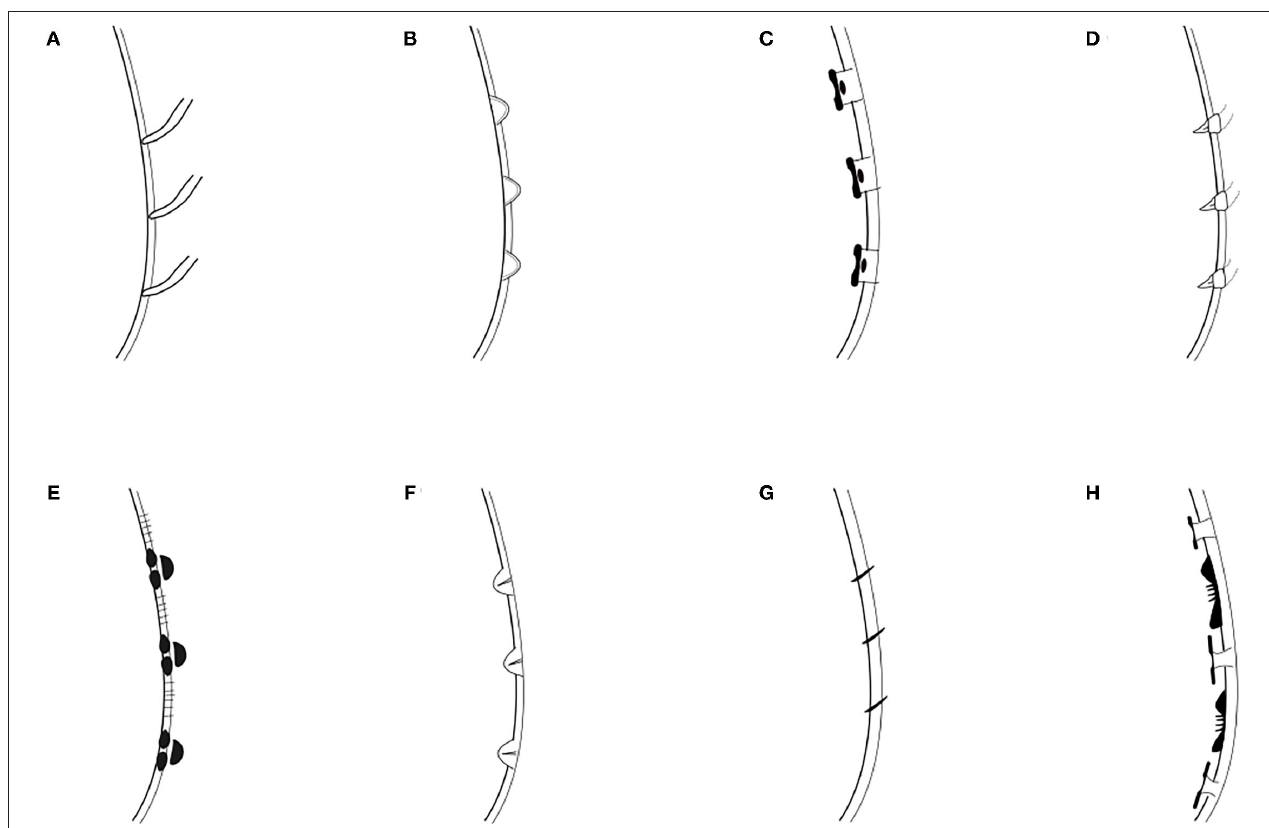
FIGURE 3 | Pre-cloacal supplements aspects of Cyatholaimidae species. (A) Tubular; (B) cup-shaped; (C) complex, consisting of a stout cylindrical body having a flat cover with a central opening; (D) papilla outer piece and inner tubular piece; (E) plate-shaped outer piece and inner cup-shaped piece; (F) pappiloid; (G) setae-like; (H) complex, with cuticle lamellated between